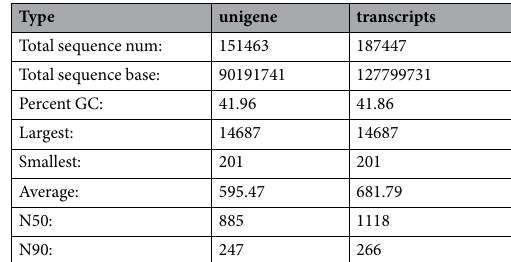
Table 1. Summary of De novo transcriptome assembly.